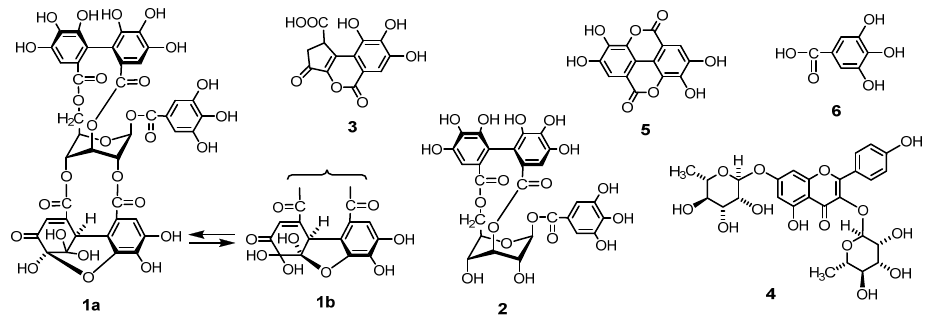
Figure 1. Structures of the main ellagitannins and related polyphenols in G. thunbergii .